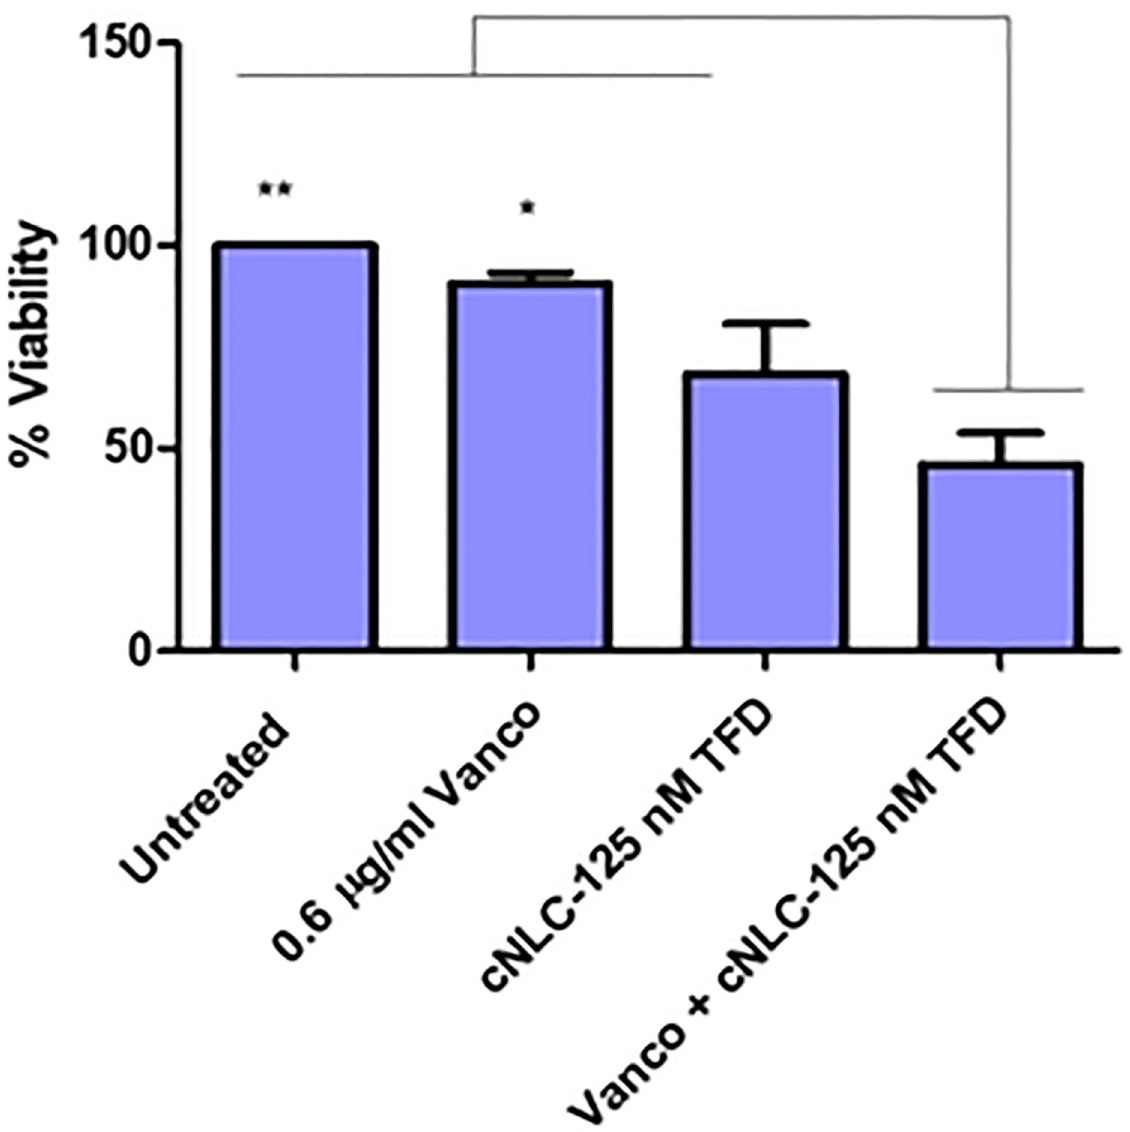
Fig 6. Synergy assay demonstrating enhanced antimicrobial effect against MRSA strain CECT 5190 when read at 570 nm. From left, untreated MRSA controls, MRSA treated with sub-MIC dose of 0.6 μ g/ml vancomycin, MRSA treated with cNLC-TFD nanocomplexes at a TFD concentration of 125 nM and MRSA treated with dual therapy of 0.6 μ g/ml free vancomycin and cNLC-125nM TFD nanocomplexes (n = 3 ± SEM, � P < 0.05, �� P < 0.01, one-way ANOVA).